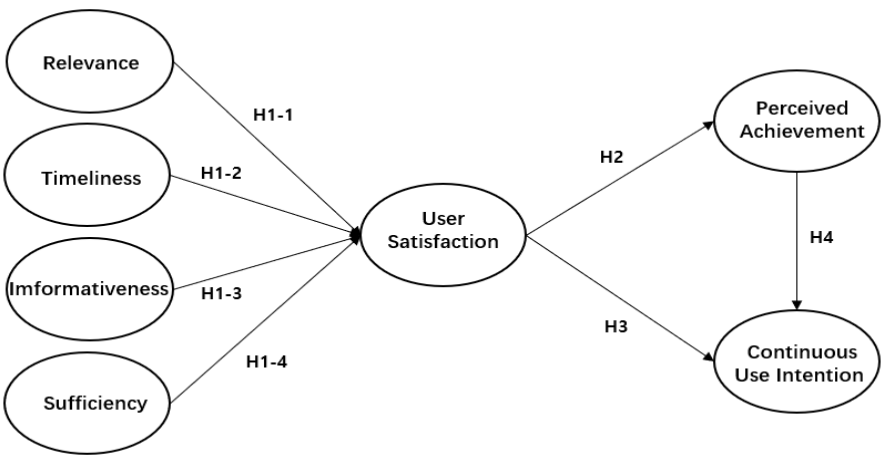
Figure 1. Research